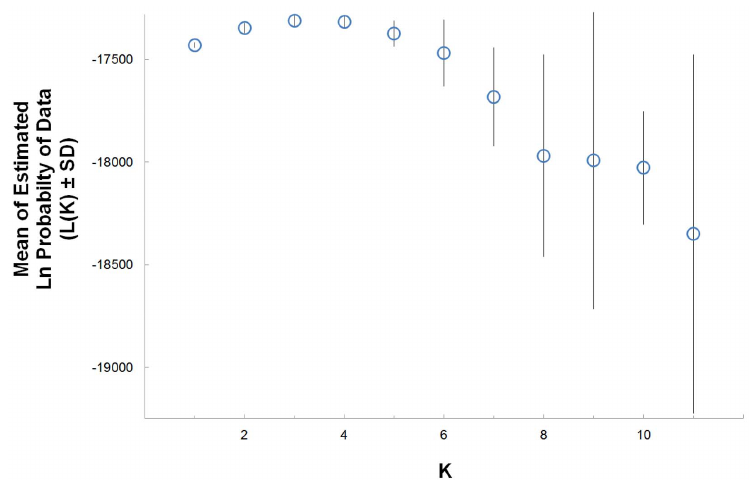
Figure 4. Mean of estimated ln probability of data using LocPrior in S TRUCTURE for K=1–11. Using S TRUCTURE H ARVESTER , the most likely K=2.